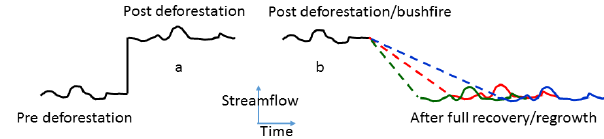
Figure 1. Increase/decrease in streamflow due to (a) deforesta- tion/clearing and (b) afforestation/bushfire